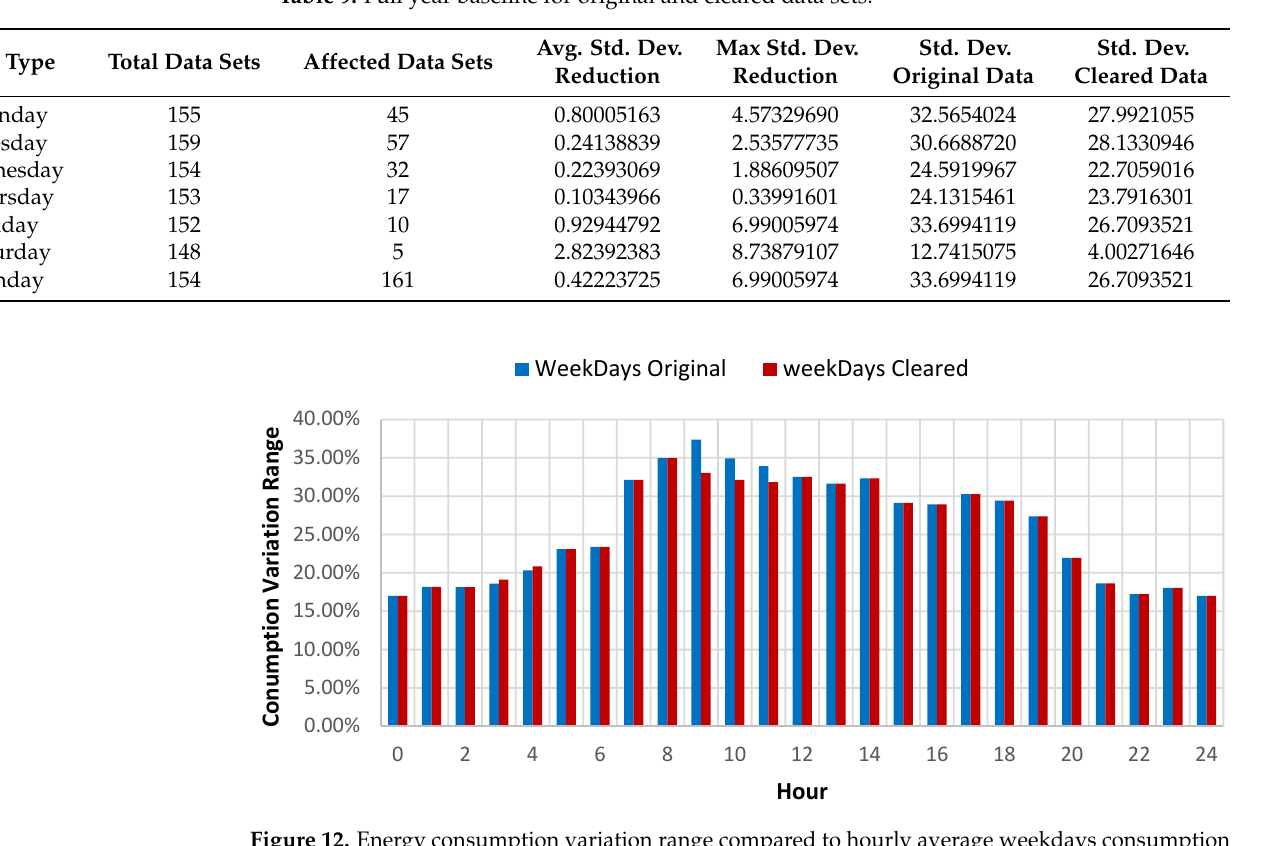
Table 11. Semester II baseline for original and cleared data sets. Table 9. Full year baseline for original and cleared data sets.